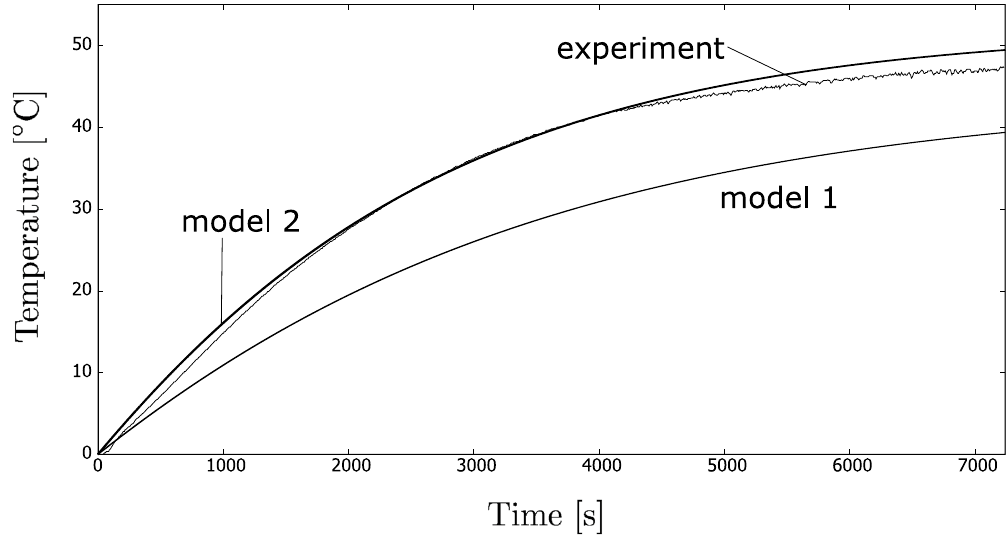
Figure 7. History of temperature increase (an example) for a nanofluid sample during the indoor experiments. The results are compared with the theoretical analysis discussed in “Theoretical analysis” section.